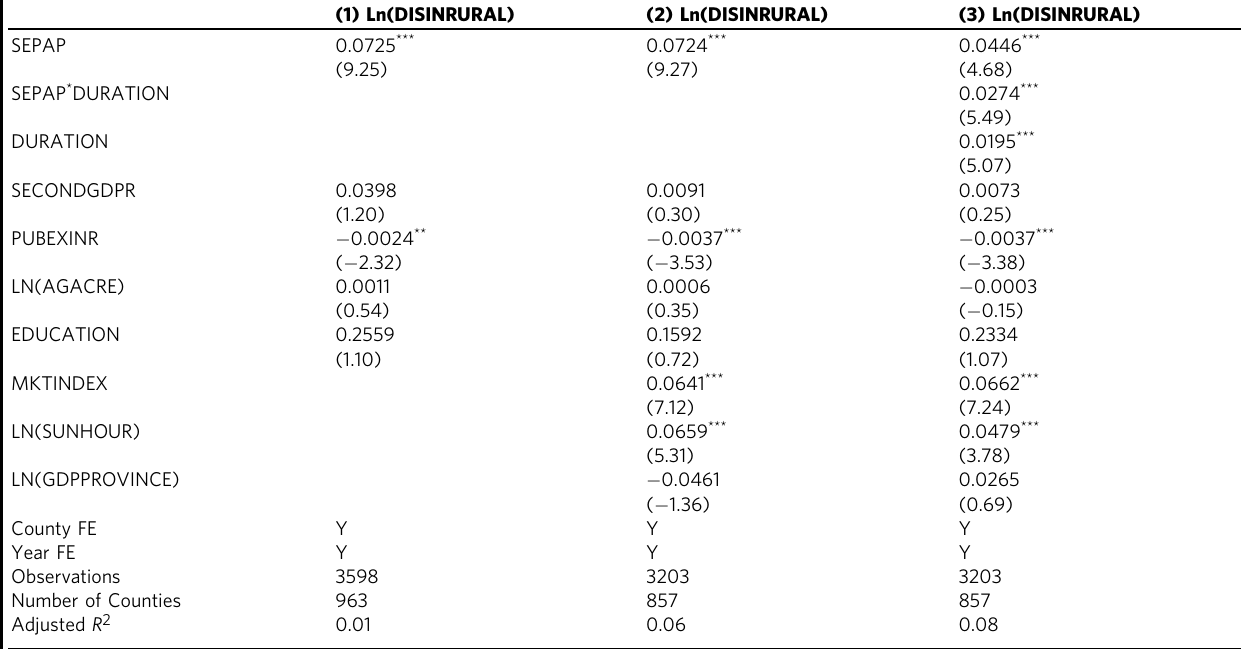
Table 1 The impact of PV policy on natural logarithm of rural per capita disposable